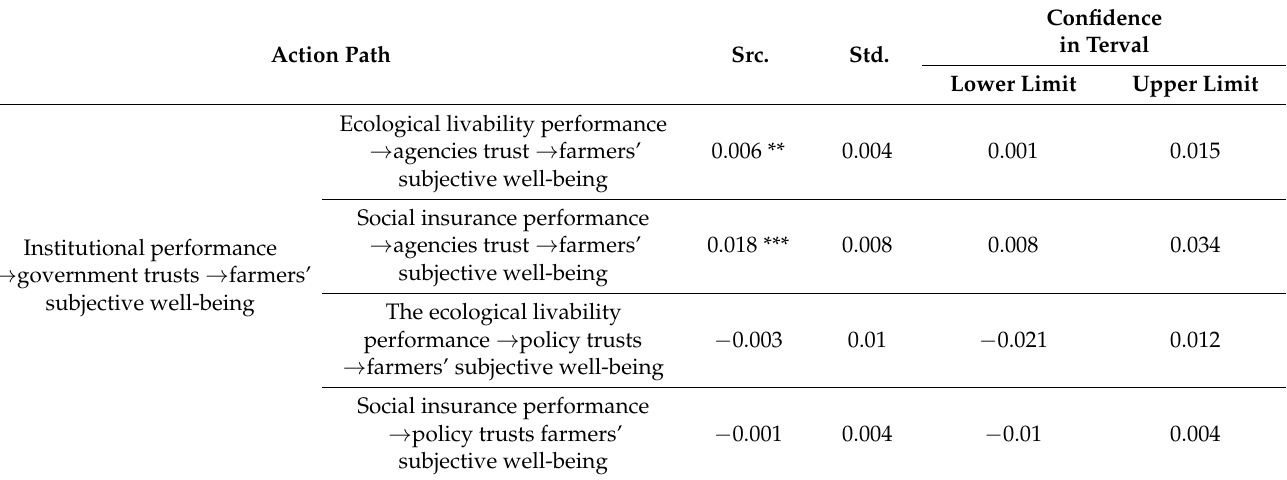
Table 6. Results and test of mediation effect. Action Path Src. Std.